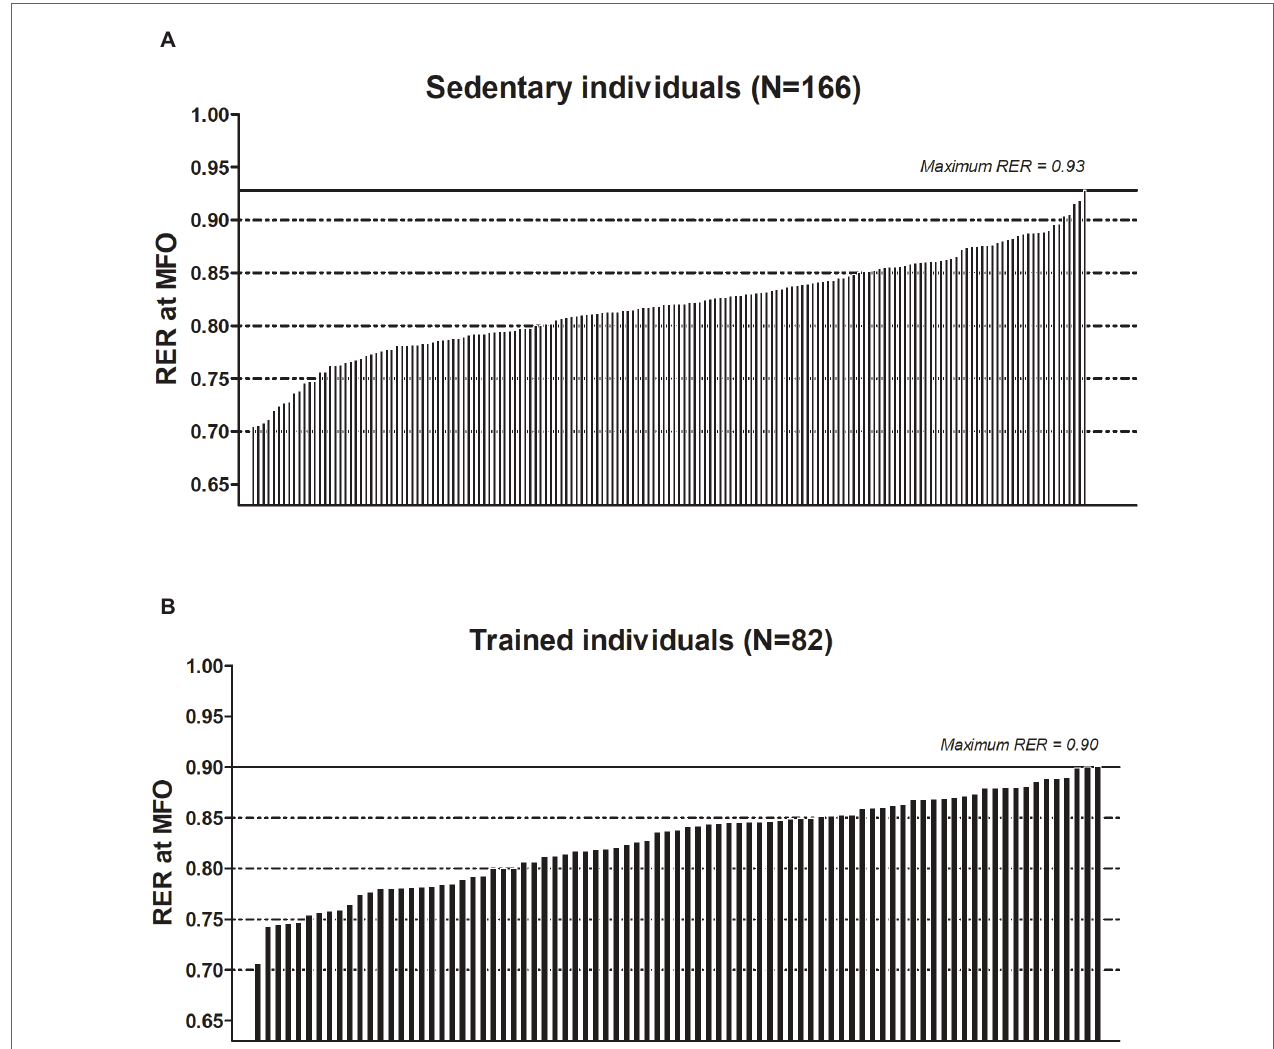
FIGURE 2 | Respiratory exchange ratio (RER) reached at the intensity that elicits the maximal fat oxidation during exercise (Fatmax) (A) in 124 young sedentary adults (83 women/41 men) and in 42 middle-aged sedentary adults (23 women/19 men) and (B) in 52 young sedentary adults (35 women/17 men) and in 30 middle-aged sedentary adults (15 women/15